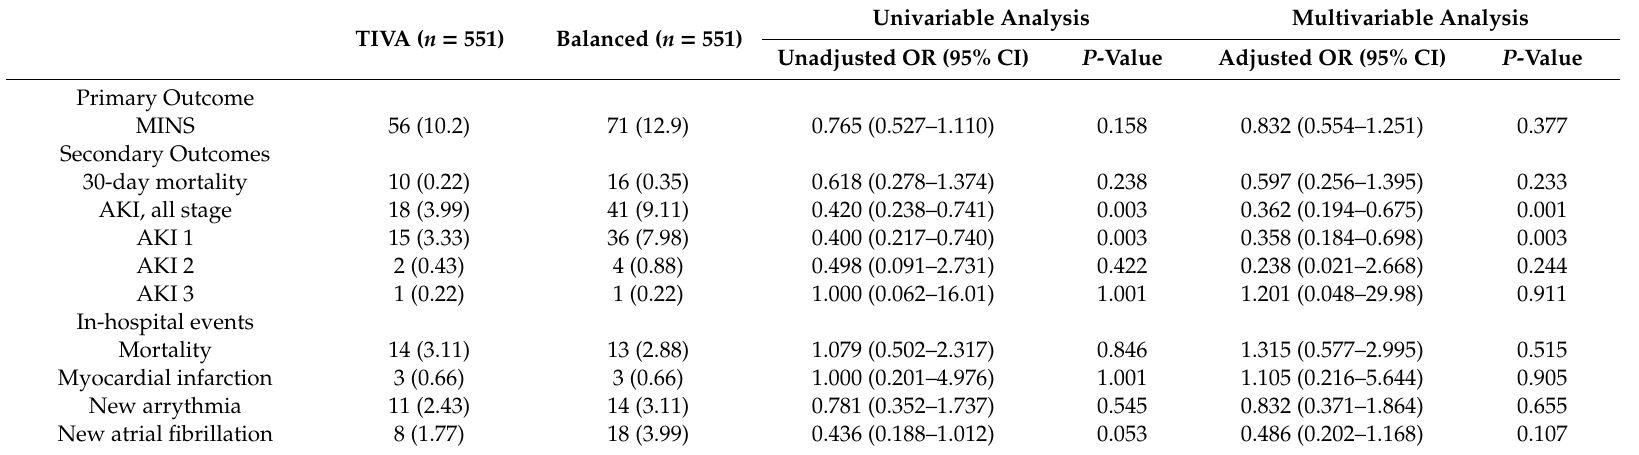
Table 4. Clinical outcomes comparing TIVA versus balanced groups in matched